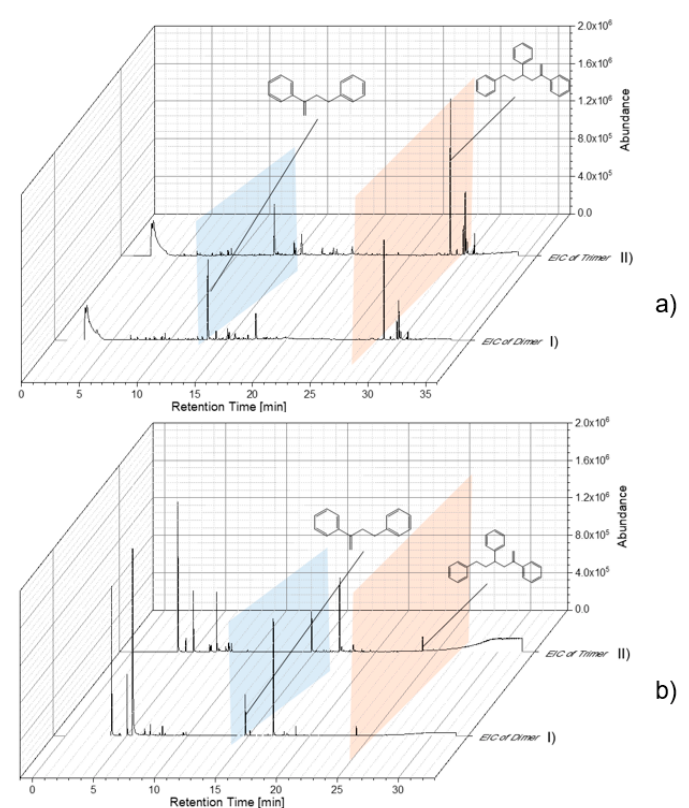
Figure 4. Evaluation of chromatogram / pyrogram of PS 78-nm particles by extracted-ion chromatogram (EIC) of dimer (I) and Trimer (II) ( a ) TD-Chromatogram (TD-GC / MS), ( b ) Pyrogram (Pyr-GC / MS).